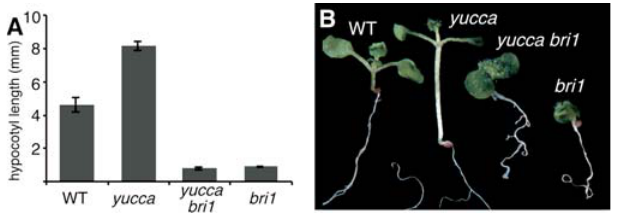
Figure 2. Enhanced Hypocotyl Elongation of yucca Mutants Requires Functional BRI1 (A) Average hypocotyl lengths of 3-d-old plants. Error bars represent standard error. (B) Ten-day-old WT, yucca, yucca bri1-116, and bri-116 seedlings.